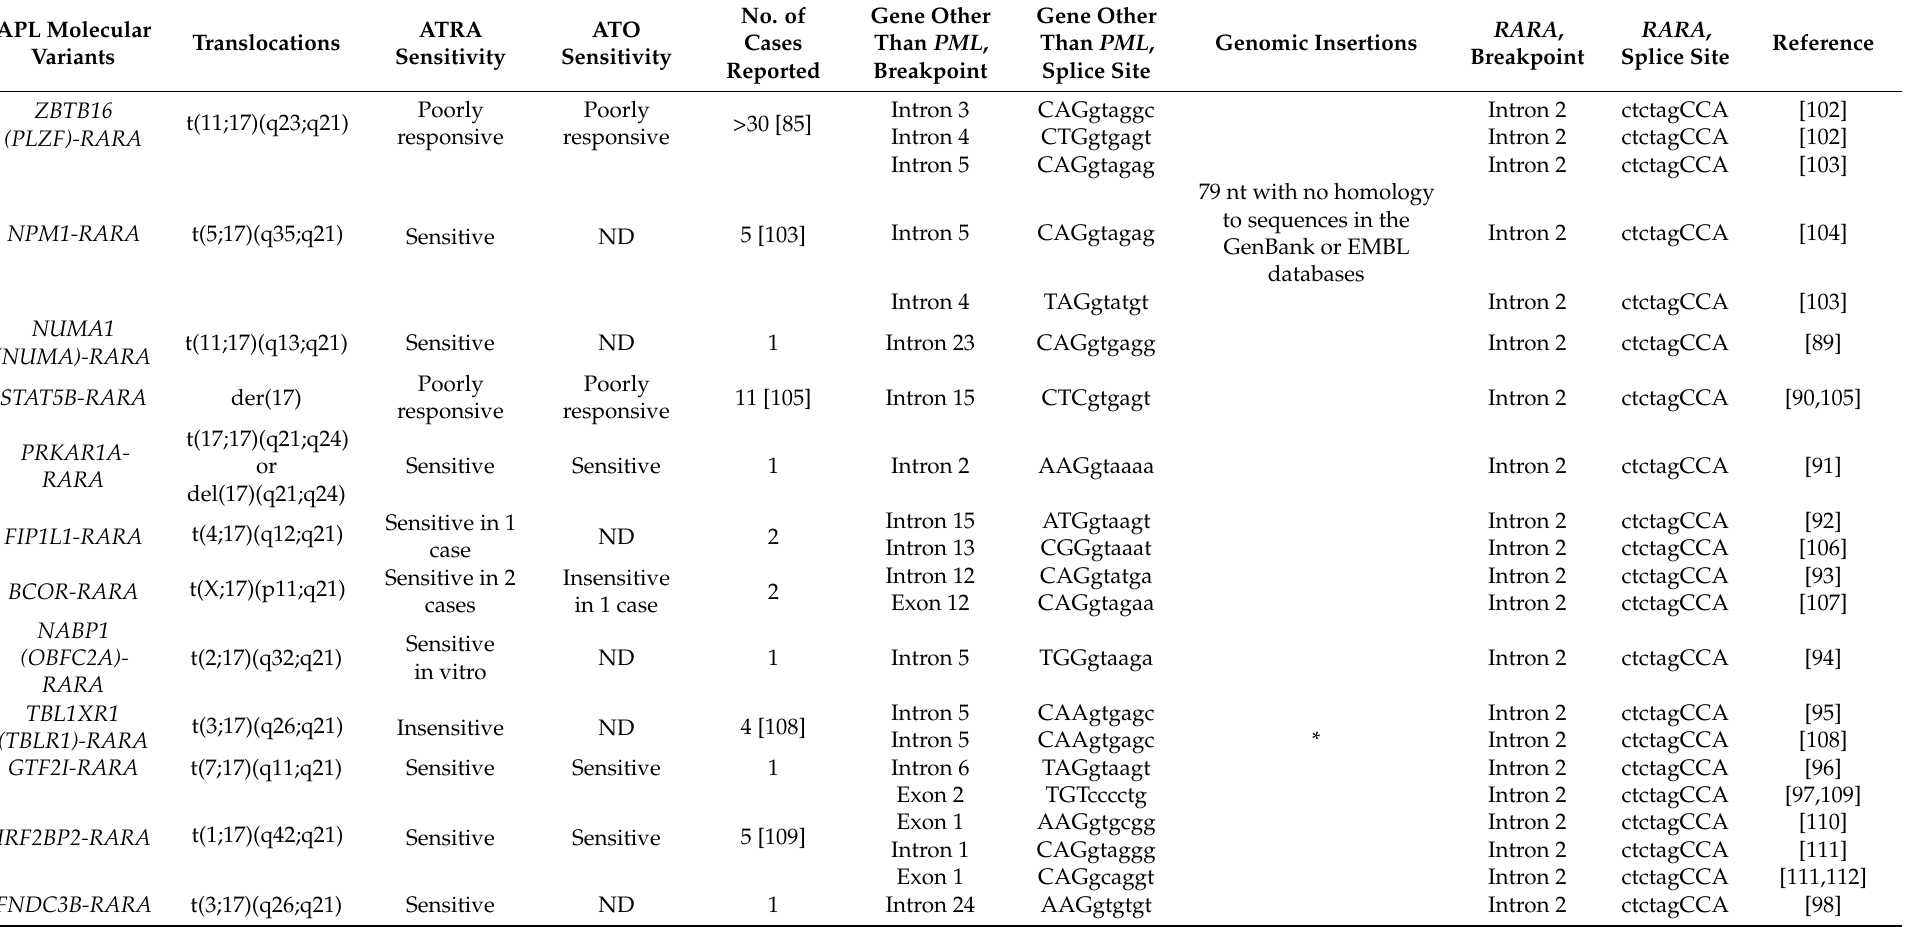
Table 2. APL molecular